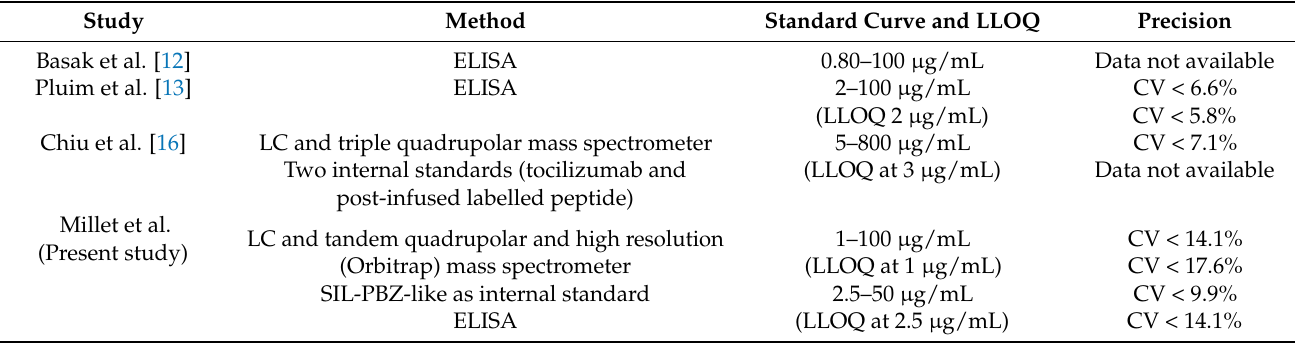
Table 5. Main characteristics of the assays published for pembrolizumab quantification and the present study. Study Method Standard Curve and LLOQ